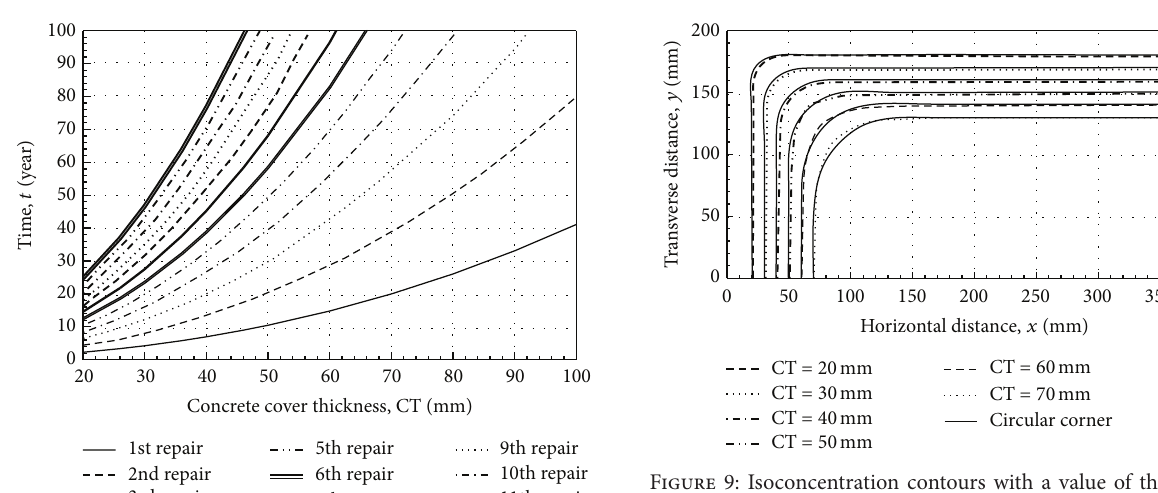
Figure 9: Isoconcentration contours with a value of the CTL for various values of concrete cover thicknesses. Circular fillets of the inner concrete cover corners, each with a radius equal to the value of CT, are overlaid. Rectangular, 800 mm by 400 mm,